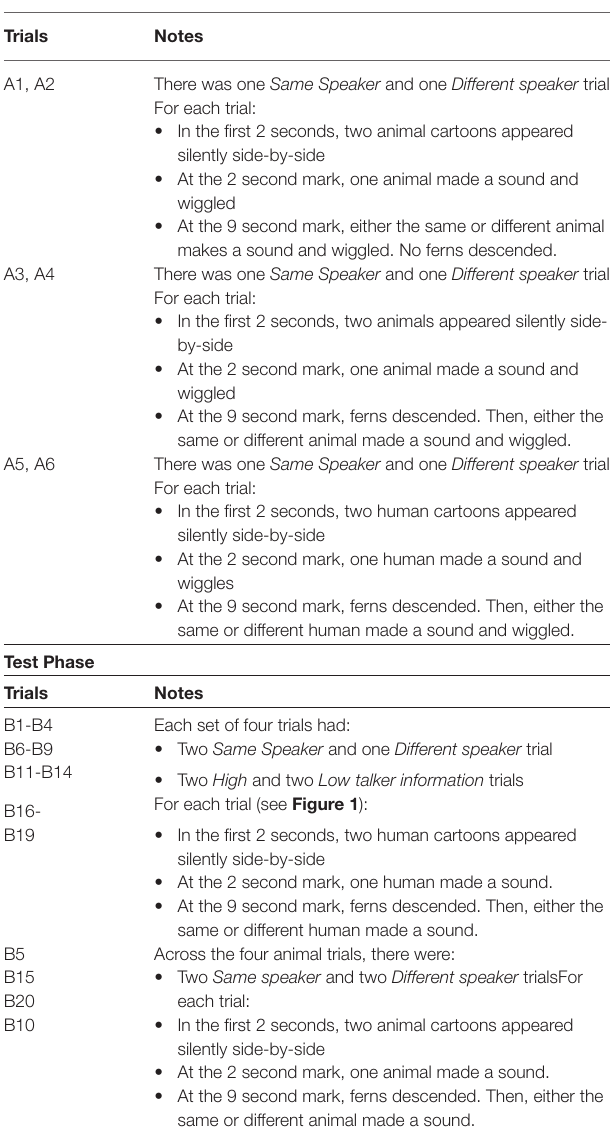
TABLE 1 | Summary of notes for trials in the task familiarization and test phases. Each trial was 14 seconds long. See Figure 1 for time course of audio. Task familiarization